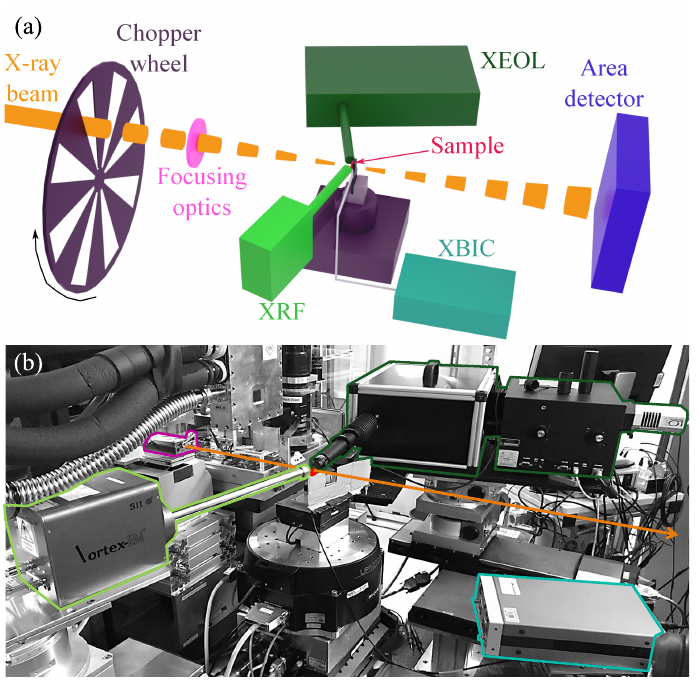
Figure 2. Experimental setup. ( a ) Scheme of the multi-modal X-ray microscopy measurement involv- ing X-ray fluorescence (XRF), X-ray beam-induced current (XBIC), X-ray excited optical luminescence (XEOL), and ptychography. ( b ) Picture of the actual setup. The area detector for ptychography is located further downstream along the beam path and not visible